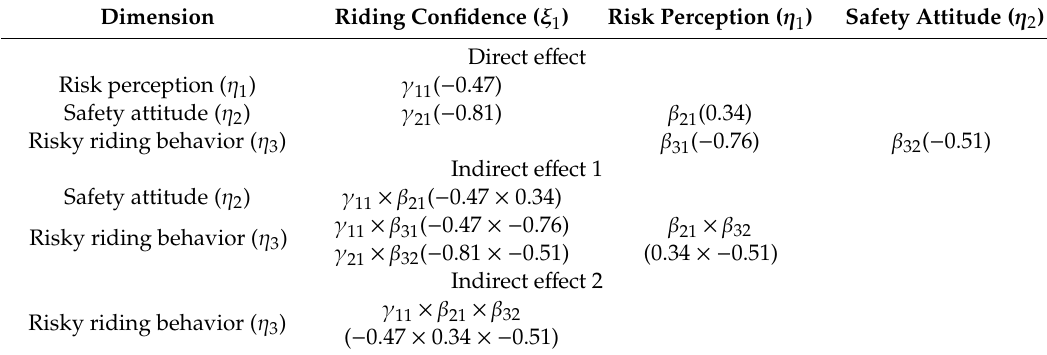
Table 4. Direct and indirect e ff ects of riding confidence, risk perception, safety attitude, and risky riding